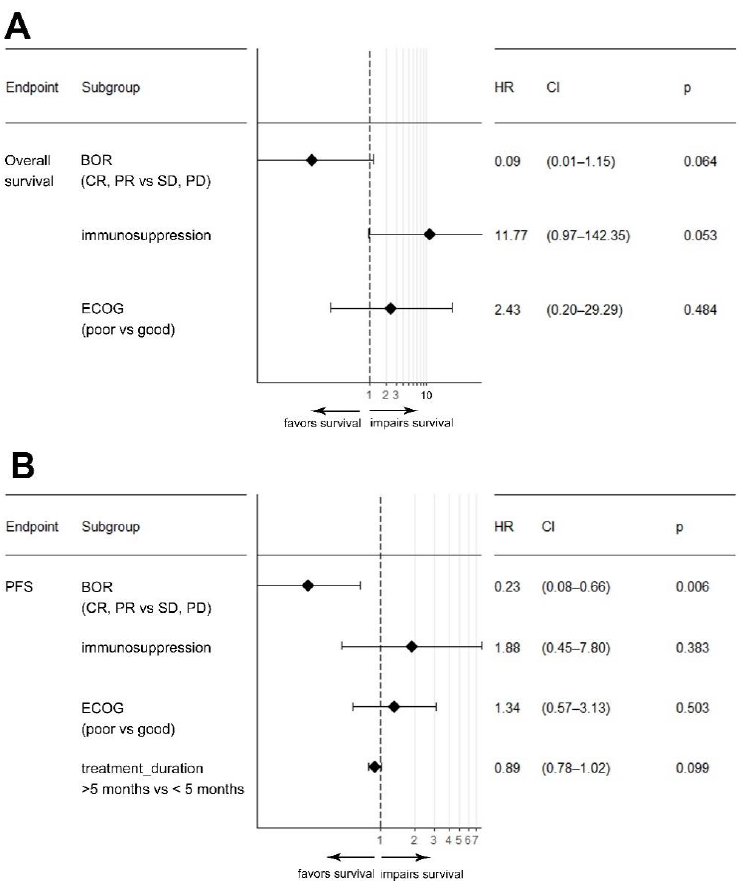
Figure 2. Forest plot depicting results from a multivariable Cox-regression model for the variables real-world tumor response, immunosuppression, and ECOG performance status on overall survival ( A ) and progression-free survival (PFS) ( B ). Abbreviations: BOR: best overall response; CR: complete response; CI: confidence interval; ECOG: eastern cooperative oncology group; HR: hazard ratio; PR: partial response; PD: progressive disease; SD: stable